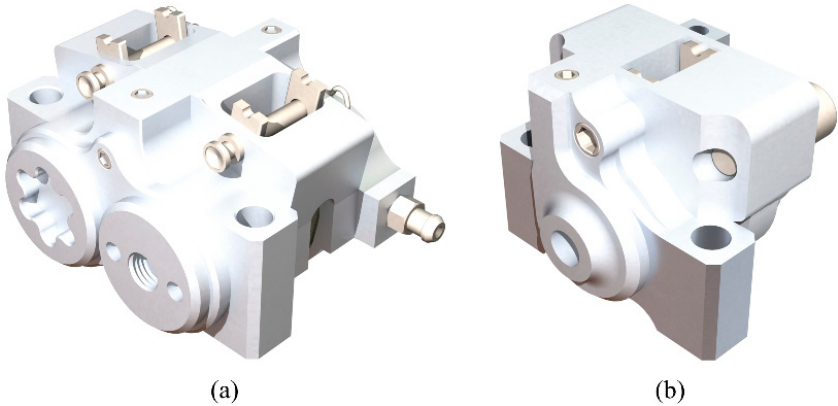
Figure 4. The ISR calipers in SolidWorks: ( a ) Front caliper and ( b ) Rear caliper.